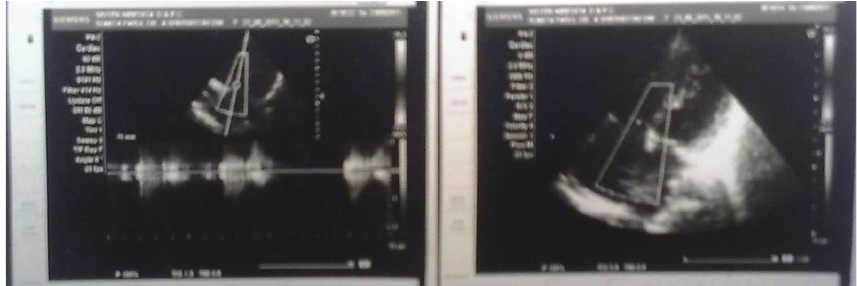
Figure 4: Echocardiographic view of ostium secundum atrial septal